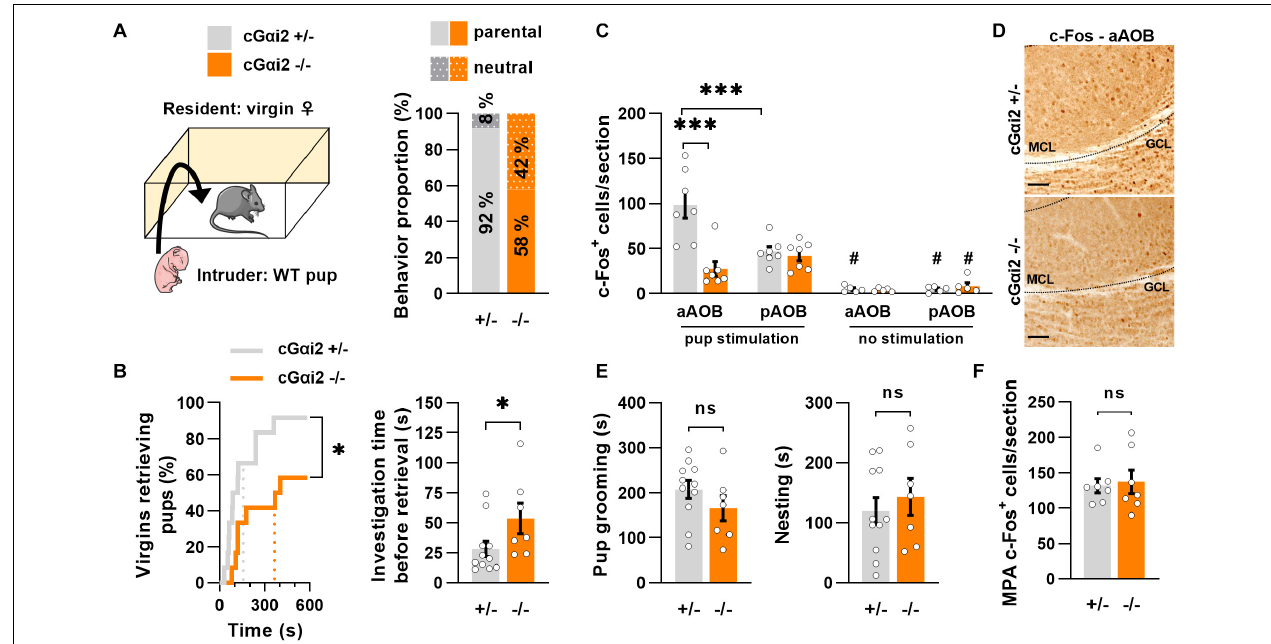
FIGURE 1 | Pup retrieval is altered in virgin cG α i2 − / − females. (A) Comparison of pup-directed behavior of cG α i2 + / − vs. cG α i2 − / − virgin female residents ( N = 12 per genotype). Wild type 1–2 day-old pups served as intruders. Females ignore (neutral) or retrieve neonates to their nest (parental). Females of both genotypes are predominantly parental (11 out of 12; 92% for cG α i2 + / − and 7 out of 12; 58% for cG α i2 − / − ). (B) Left, proportion of females retrieving pups over